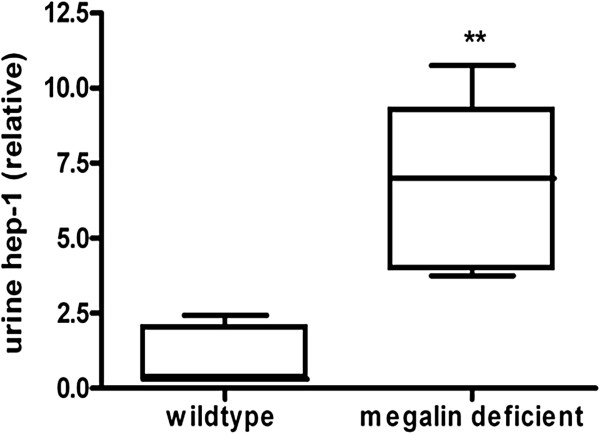
Hepcidin-1 in urine of C57Bl/6 Wild type mice (n = 5) and mice with kidney-specific megalin deficiency (n = 5). Urine was normalized for creatinine levels. Data are depicted as lower quartile, median and upper quartile (boxes), and minimum and maximum ranges (whiskers). **,P < 0.01;megalin deficient vs. wild type mice (by Mann Whitney test).